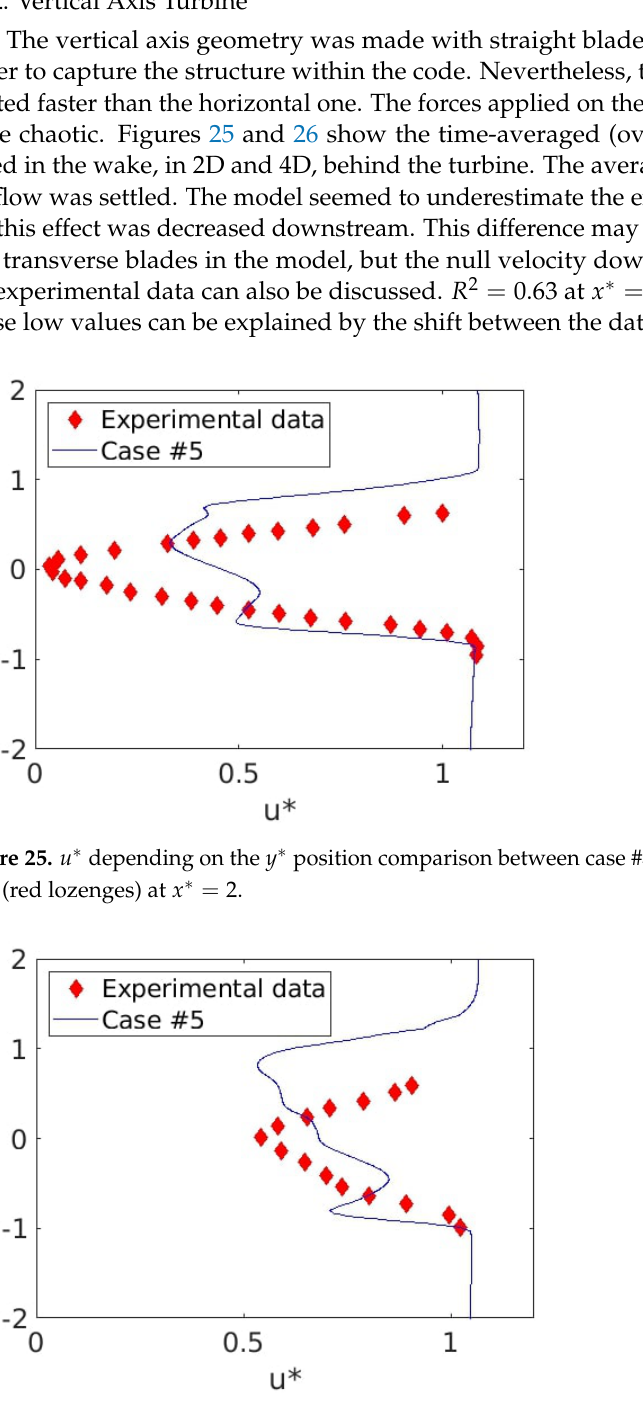
Figure 26. u ∗ depending on the y ∗ position comparison between case #5 (blue line) and experimental data (red lozenges) at x ∗ =